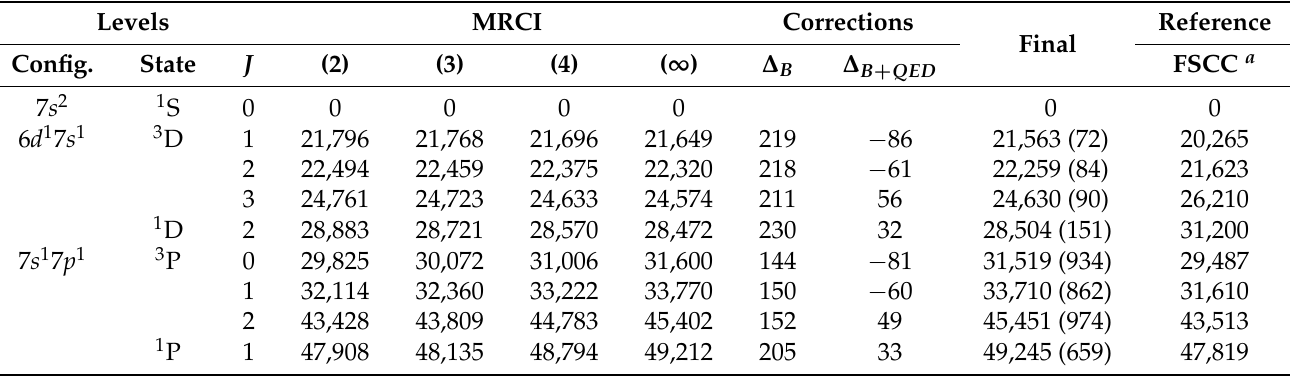
Table 3. Calculated energies (in cm − 1 ) of the ground and the low-lying excited states of the Lr + ion obtained from the MRCI model using the double- (2), triple (3) and quadruple-zeta (4) basis sets, and the energy values derived at the complete basis set limit ( ∞ ), together with the final energy values (Final) that take into consideration the energy corrections obtained for the Breit ( ∆ B ) and QED ( ∆ B + QED ) contributions, compared with the FSCC results.